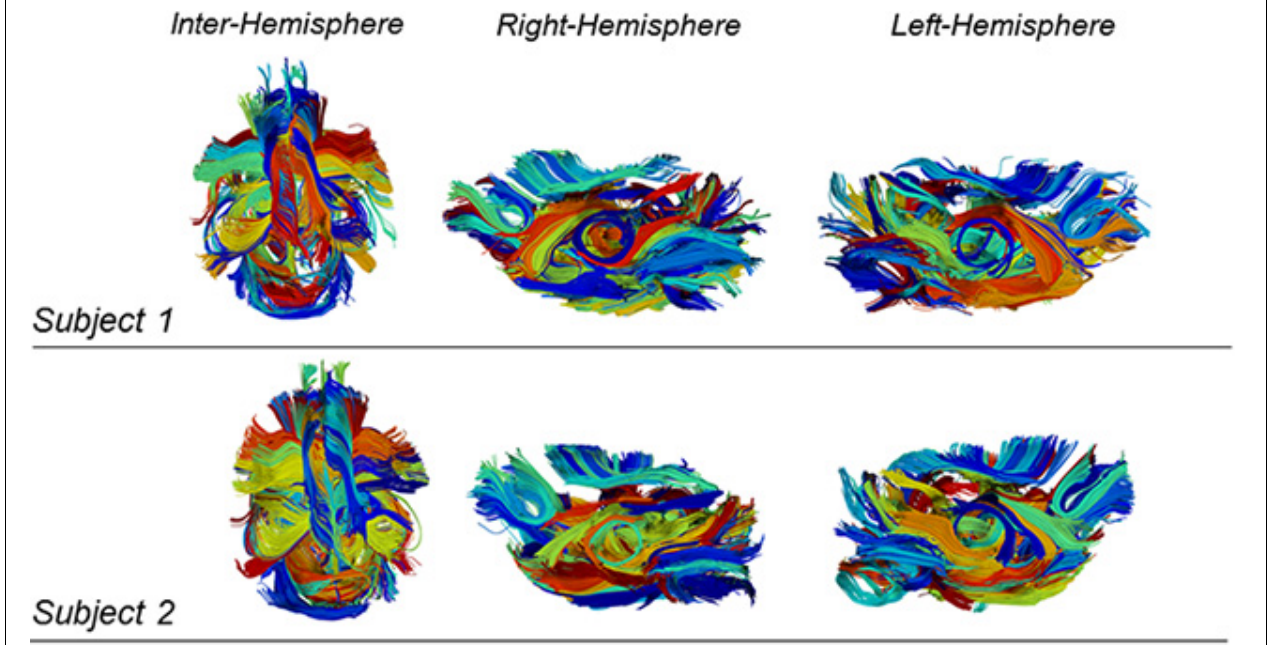
FIGURE 6 | Example of intra-subject clustering results on two mouse tractographies. Each color is associated to a cluster of fibers. The two subjects have different color mappings because inter-subject clustering is